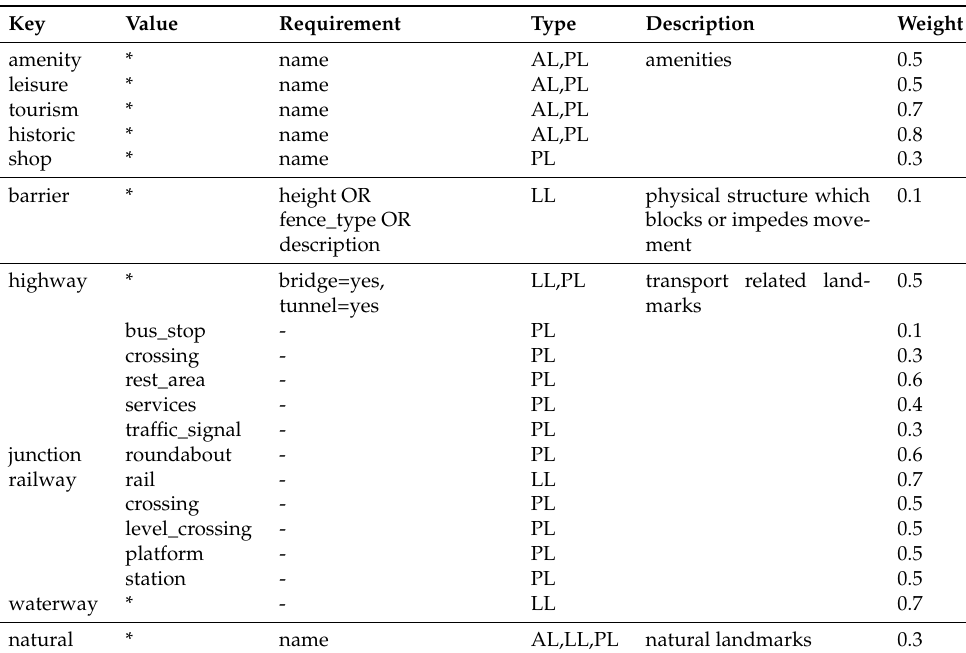
Table 5: OSM tags related to